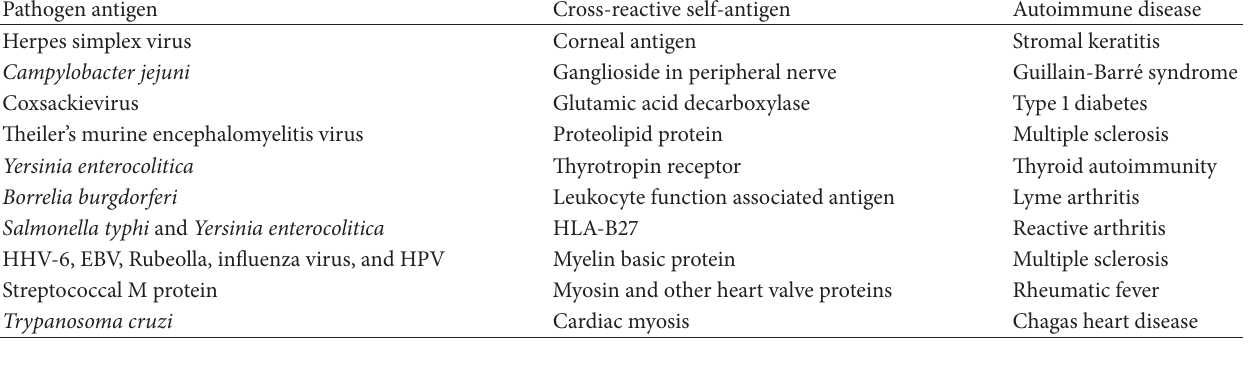
Table 3: Examples of bacterial and viral antigens that can cross-react with self-antigens with potentially resultant diseases.